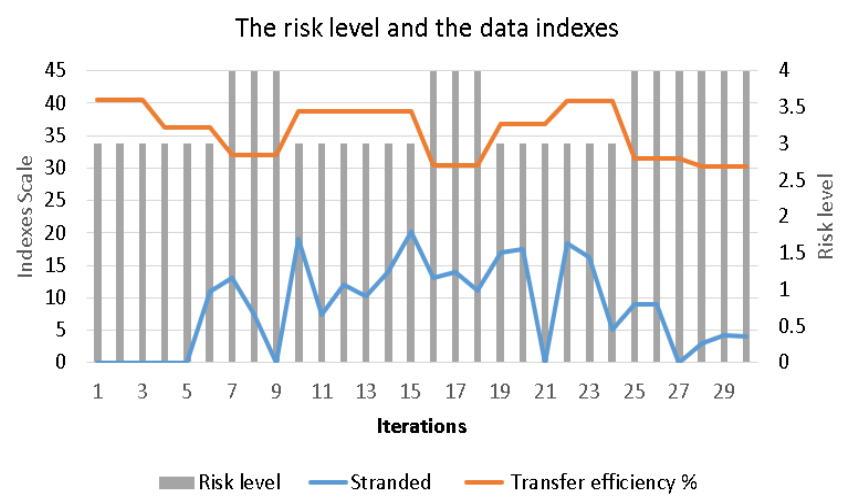
Figure 6. Correlations between the inputs and the risk level.